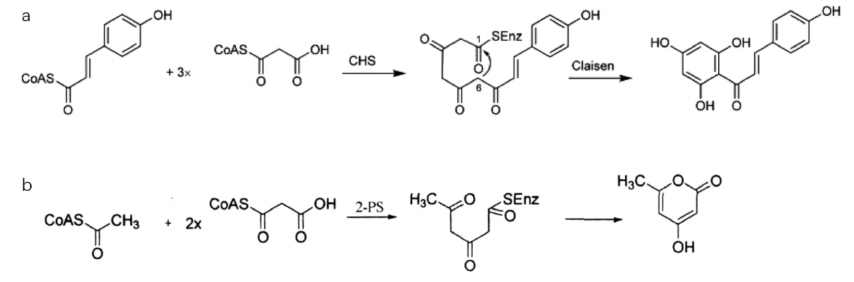
Figure 1. Reaction catalyzed by type-III